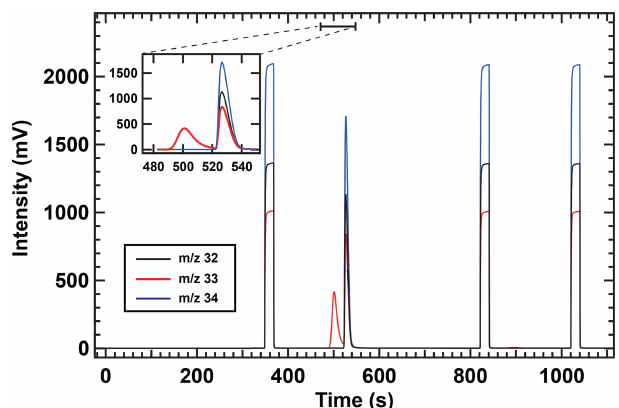
Figure 7. IR-MS chromatogram of atmospheric samples collected at the Suzukakedai campus of the Tokyo Institute of Technology. Liquid N 2 removal from trap 4 occurred at 0s in the purification system. Reference OCS was injected three times starting at 350, 825, and 1025s for